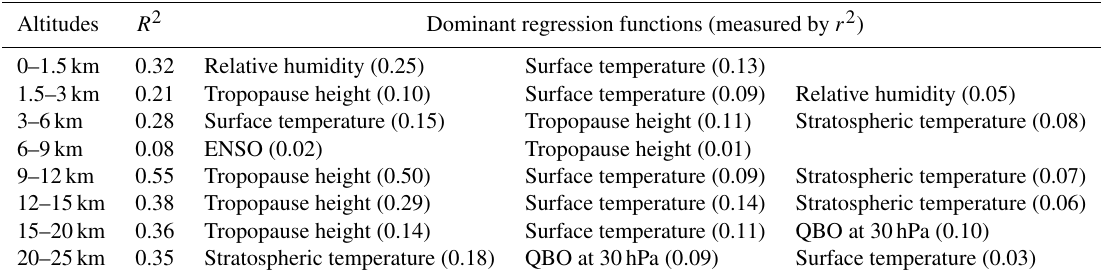
Table 2. Coefficient of determination, R 2 , and dominant contributors to the regression, based on coefficients of determination of individual regression functions ( r 2 ), resolved by